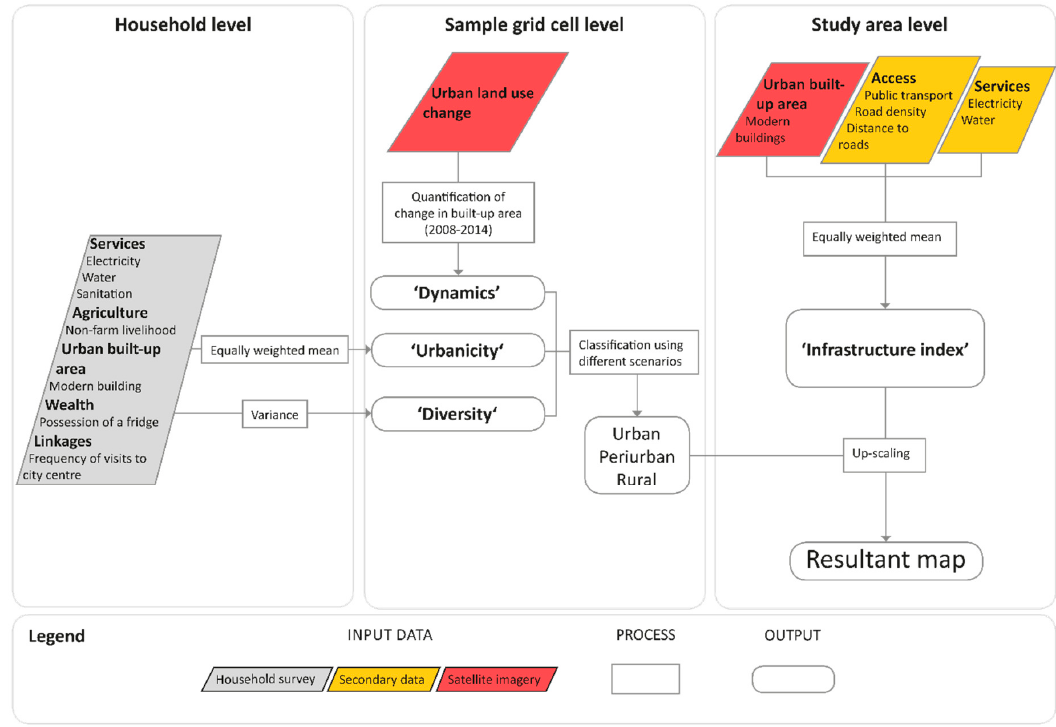
Figure 2. Methodological framework.